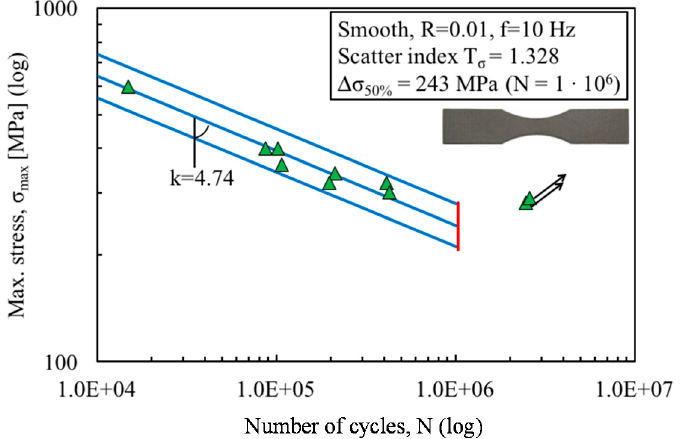
Figure 3. Fatigue life of smooth samples.